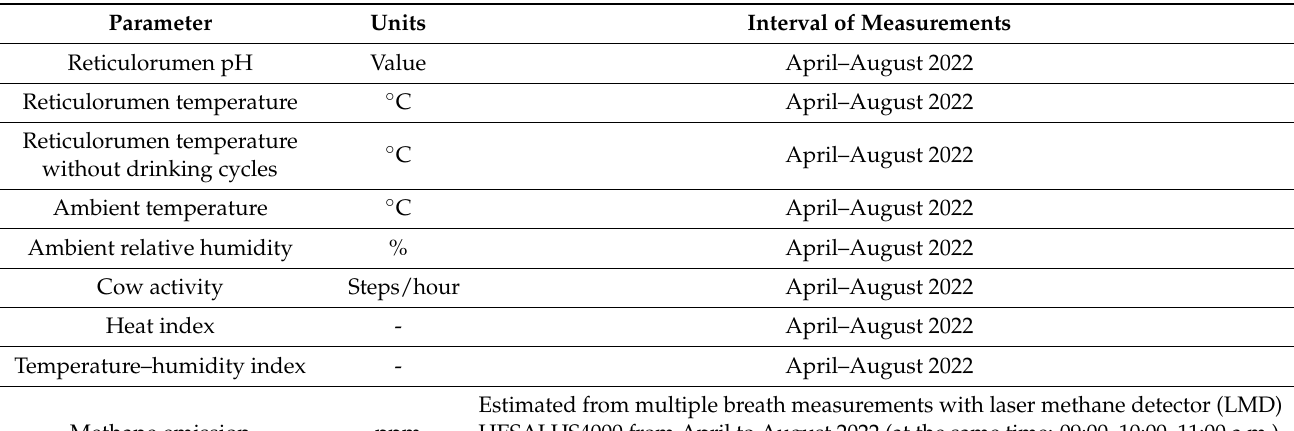
Table 2. Parameters and intervals of their